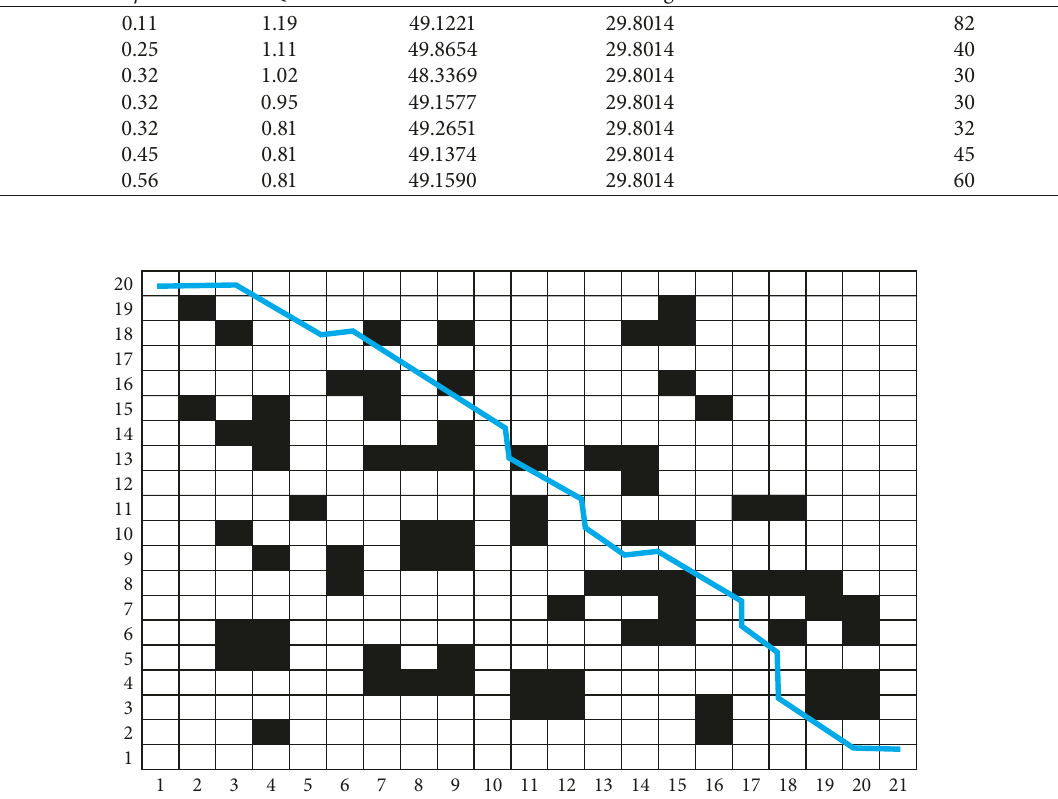
Figure 6: Basic ant colony algorithm path planning optimal path.